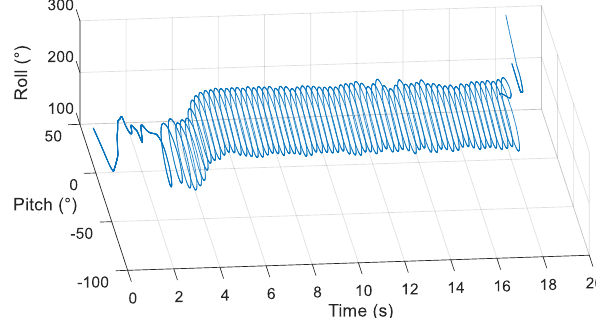
Figure 20. 2D scanning attitude of the airdrop experiment.